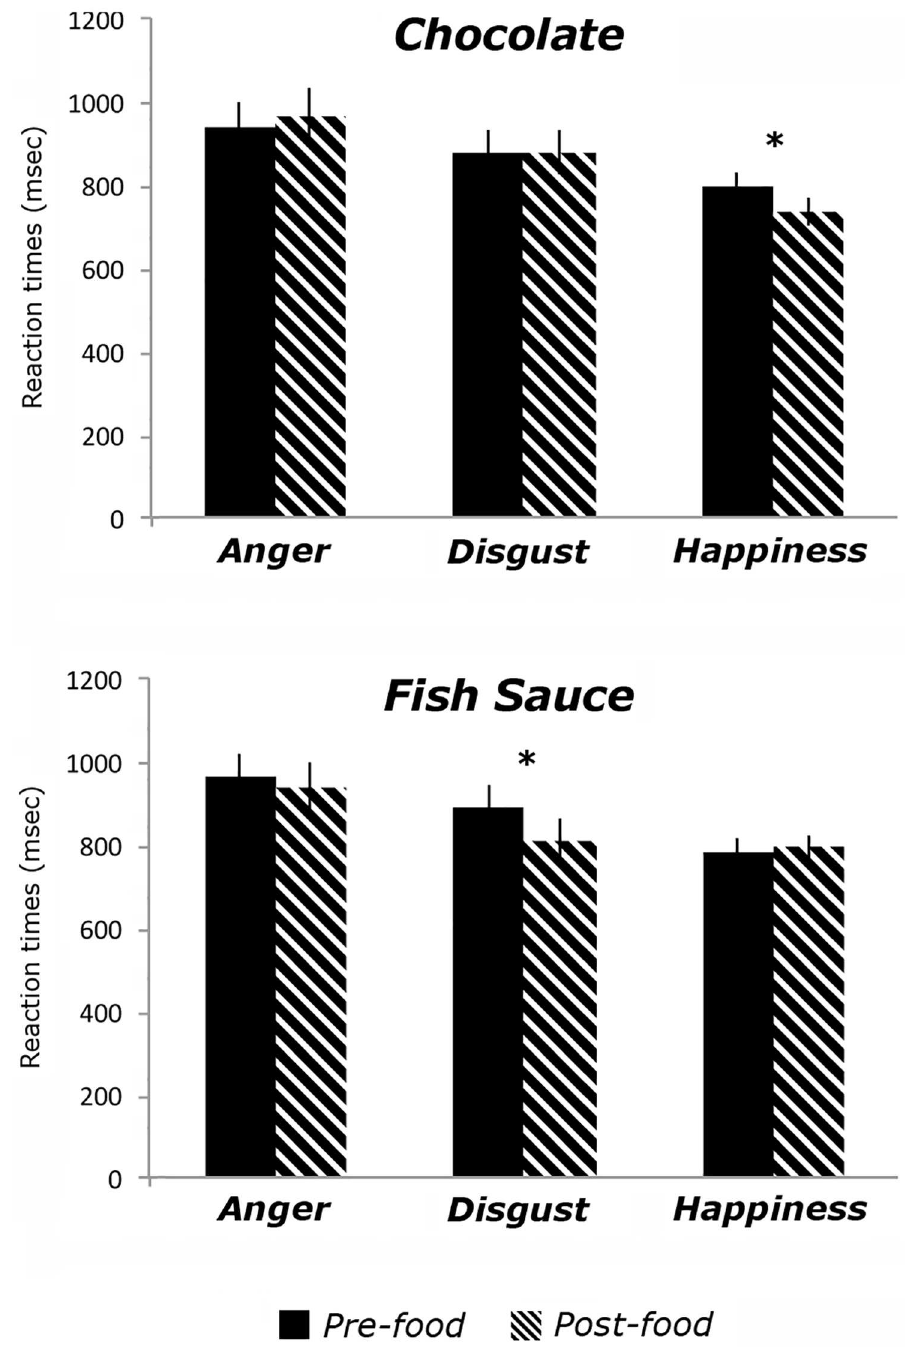
Fig 3. Results for the Emotion Recognition Task. Graphs showingperformance on the emotion recognition task, before and after either dark chocolate(top panel)or fish sauce (bottom panel)intake. Mean ReactionTimes (msec, y axis) in recognizing angry, disgustedor happyfacial expressions were measured. Error bars reflect standarderror of the mean, and asterisk indicates p < 0.05, two-tailed.